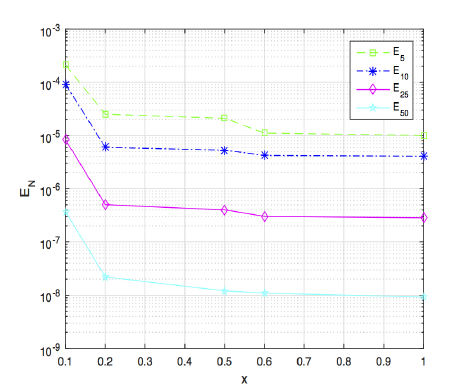
Figure 4. L 1 convergence results at x = [0 , 1] for N = 5 , 10 , 25 , and 50.